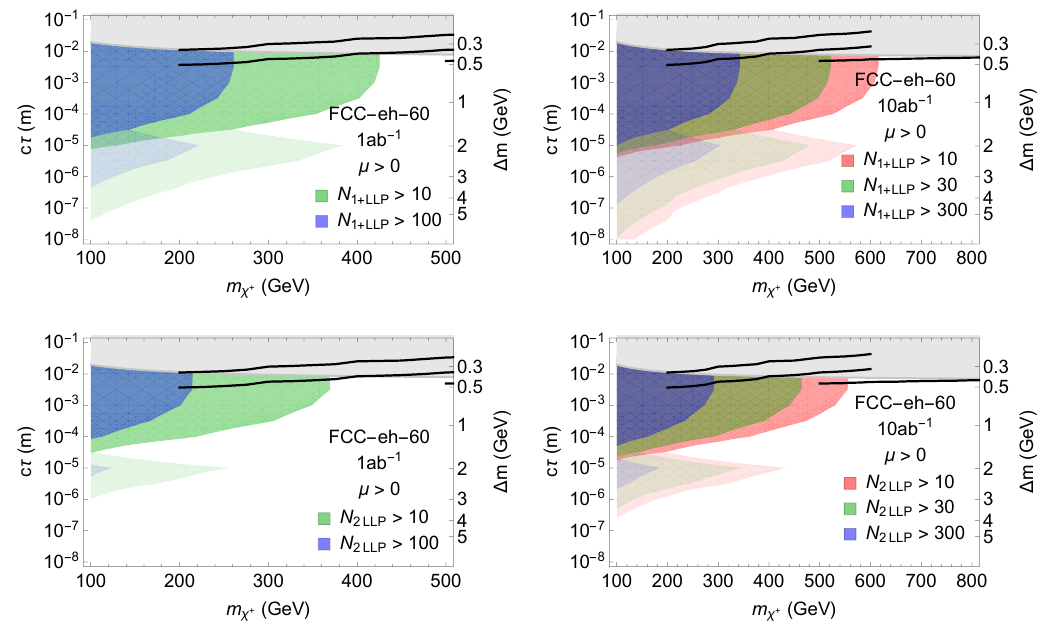
Figure 8 . Regions in the ( m (cid:31) (cid:6) ; c(cid:28) ) Higgsino parameter plane where more than the indicated number of one (top) or two (bottom) LLPs are observed at the FCC-eh with a 60 GeV electron beam and 1 ab (cid:0) 1 (left) or 10 ab (cid:0) 1 (right) of luminosity. Light shading indicates the uncertainty in the predicted number of events due to di(cid:11)erent hadronization and LLP reconstruction assumptions. As for the LHeC estimate in (cid:12)gure 7, the green region represents our 2 (cid:27) sensitivity estimate in the presence of (cid:28) backgrounds. For 10 ab (cid:0) 1 , red shading is an optimistic sensitivity estimate in case background rejection is better than we anticipate. For comparison, the black curves are projected bounds from disappearing track searches, for the HL-LHC (optimistic and pessimistic) and the FCC-hh, see (cid:12)gure